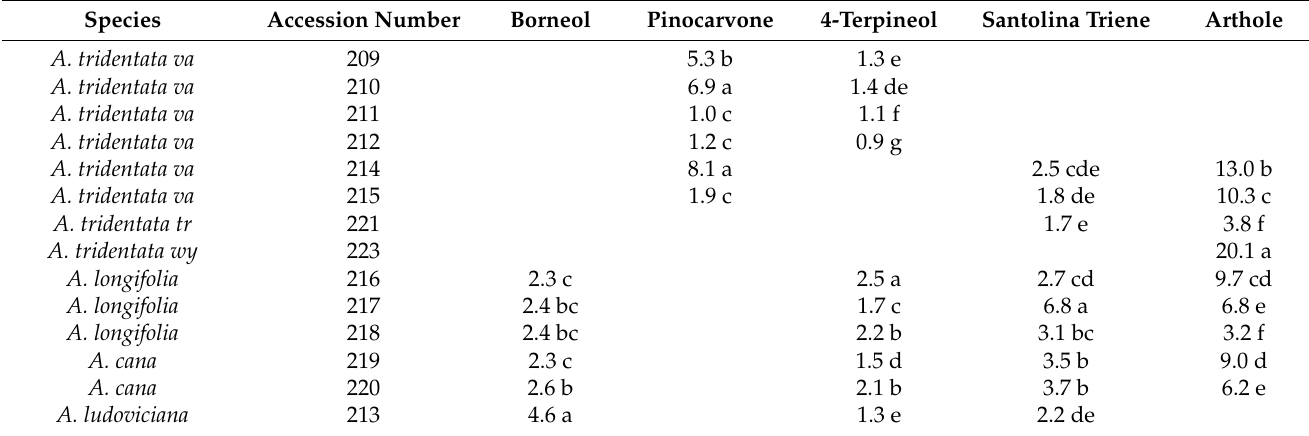
Table 5. Mean borneol, pinocarvone, 4-terpineol, santolina triene and arthole (all in %) from six species and their corresponding collection number. Blank cells indicate the constituents were not obtained from these accessions. A. tridentata va = A. tridentata Nutt. var. vaseyana ; A. tridentata tr = A. tridentata Nutt. var. tridentata ; A. tridentata wy = A. tridentata Nutt. var. wyomingensis .